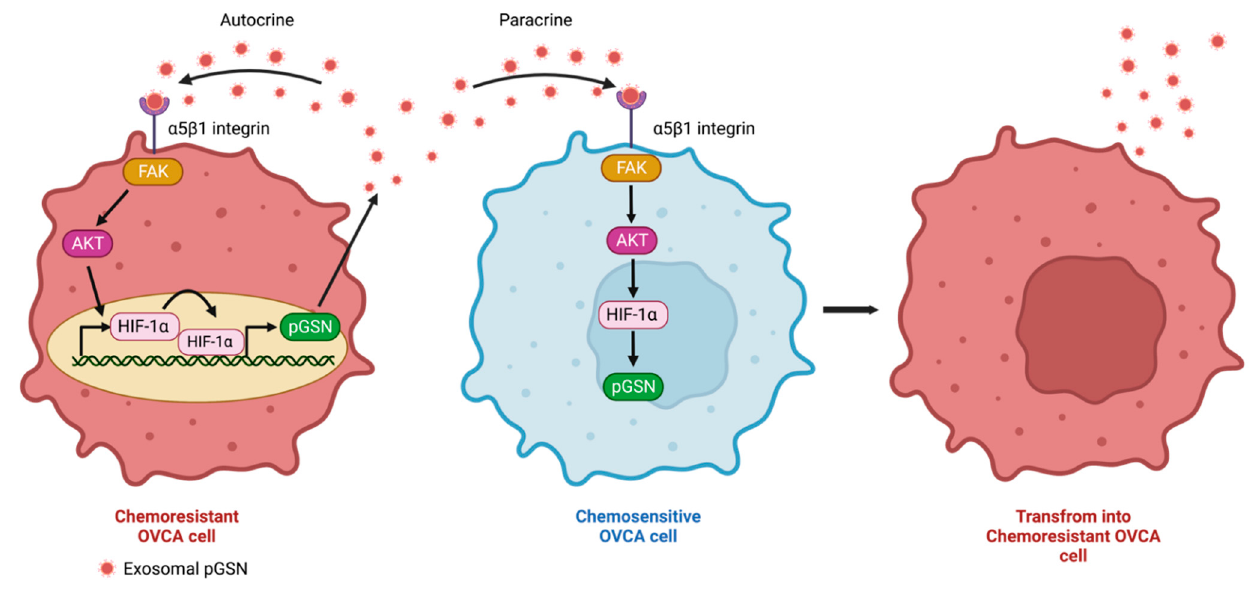
Figure 2. Autocrine and paracrine action of pGSN. Exosomal pGSN derived from chemoresistant OVCA cells transforms chemosensitive cells into chemoresistant OVCA cells via the α 5 β 1 integrins/FAK/Akt/HIF-1 α axis (Paracrine action). In chemoresistant OVCA cells, exosomal pGSN increases the promoter region binding of HIF1 α and enhances exosomal pGSN production. Thus, exosomal pGSN forms a positive feedback loop of pGSN production via α 5 β 1 integrins/FAK/Akt/HIF-1 α axis (Autocrine action). pGSN, plasma gelsolin; FAK, focal adhesion kinase; Akt, Ak strain transforming; HIF-1 α , hypoxia-inducible factor 1-alpha. Figure designed using BioRender.